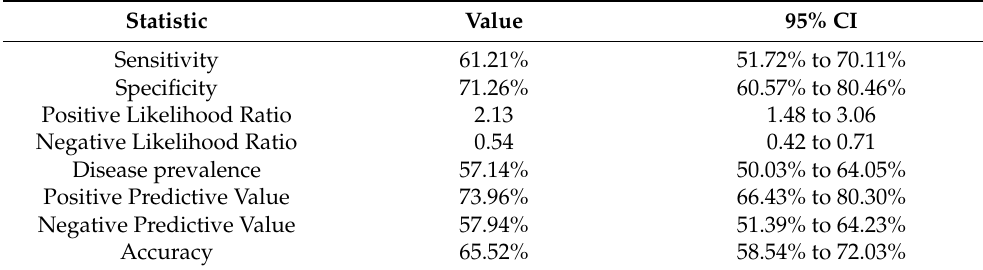
Table 3. CCE evaluation as a diagnostic test.